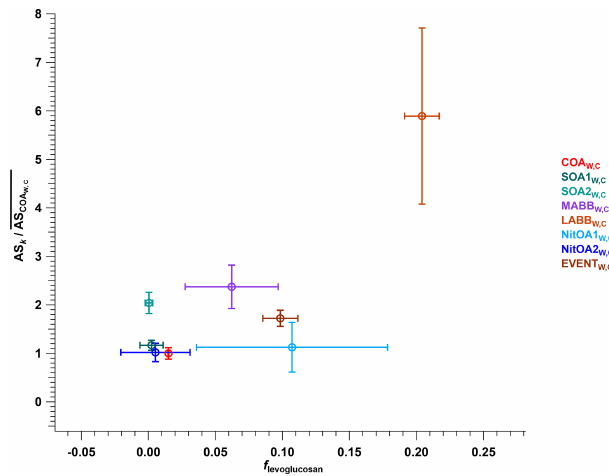
Figure 6. Relative apparent sensitivity AS k / AS COA tion of levoglucosan fraction for all factors resolved from the cPMF of the winter dataset, except for CSOA W , C . Error bars denote stan- dard